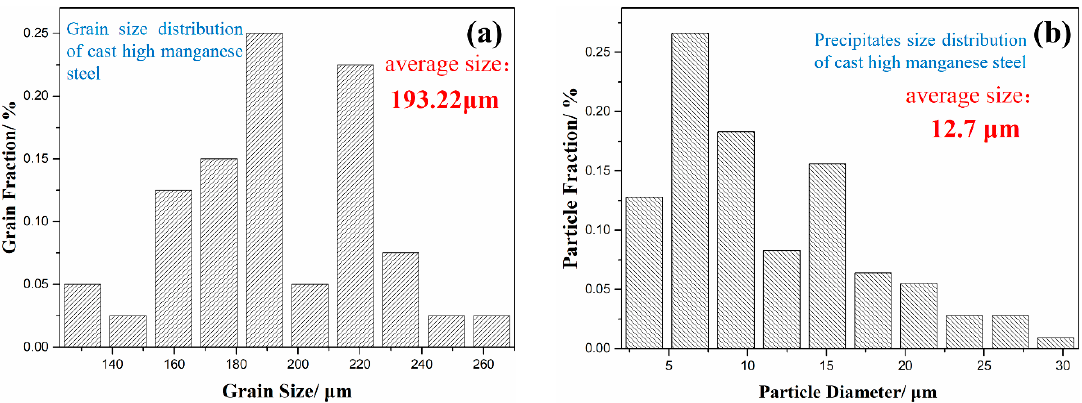
Figure 9. Size distributions of austenite grain ( a ) and precipitates ( b ) in cast high-manganese steel.